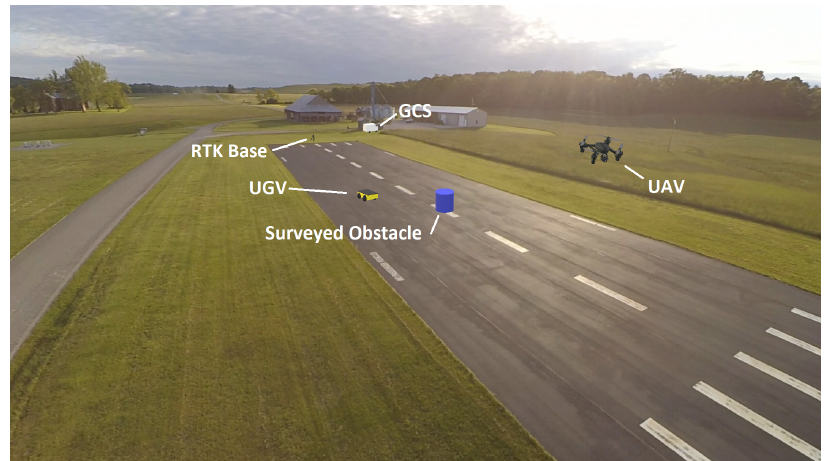
Figure 7. Kentland Farm experimental setup. GCS: Ground Control Station.